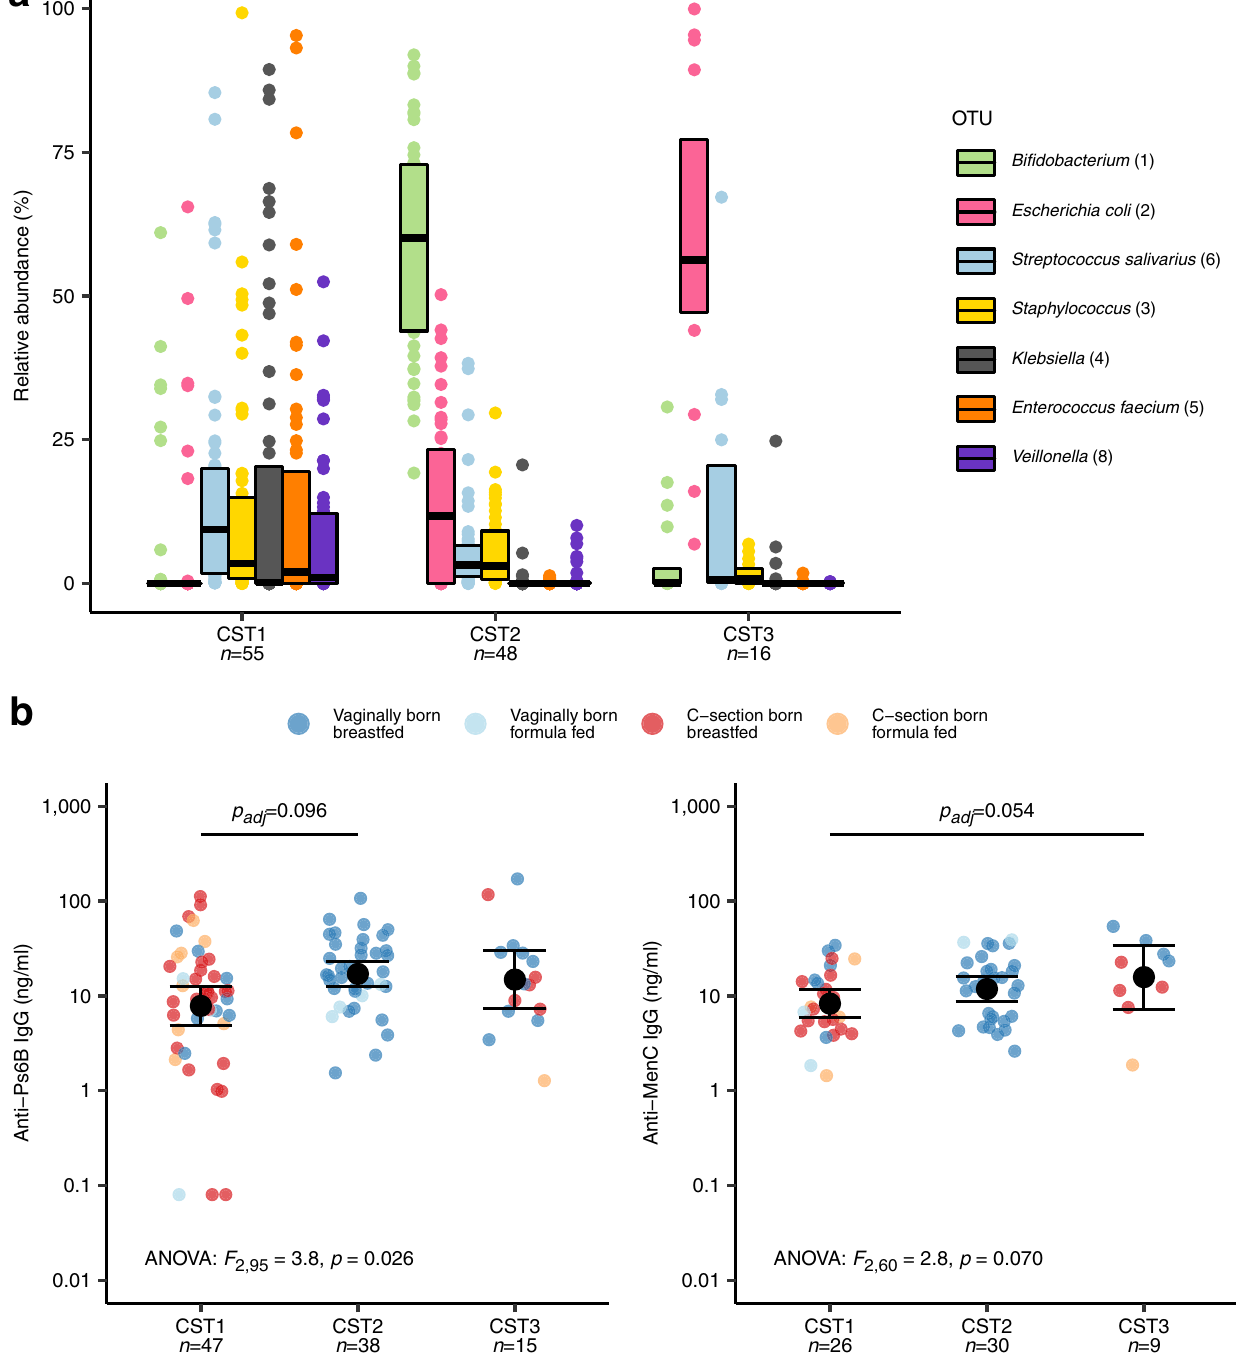
twofold higher in infants with CST2 (GMC 17.05ng/ml [95% CI 12.64 – 23.00], adjusted p =0.096) as well as in infants with CST3 (GMC 14.85 ng/ml [95% CI 7.36 – 29.97], adjusted p =0.202), though only the comparison of anti-Ps6B responses between CST1 and CST2 infants wassigni fi cant.Weobservedsimilaroverallassociationsbetweenweek oneCSTsandIgGresponsesagainstmostotherpneumococcalvaccine